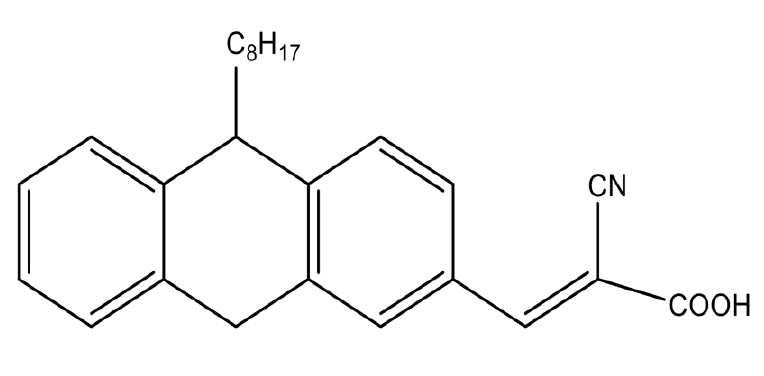
Figure 1. Chemical structure of the organic dye.